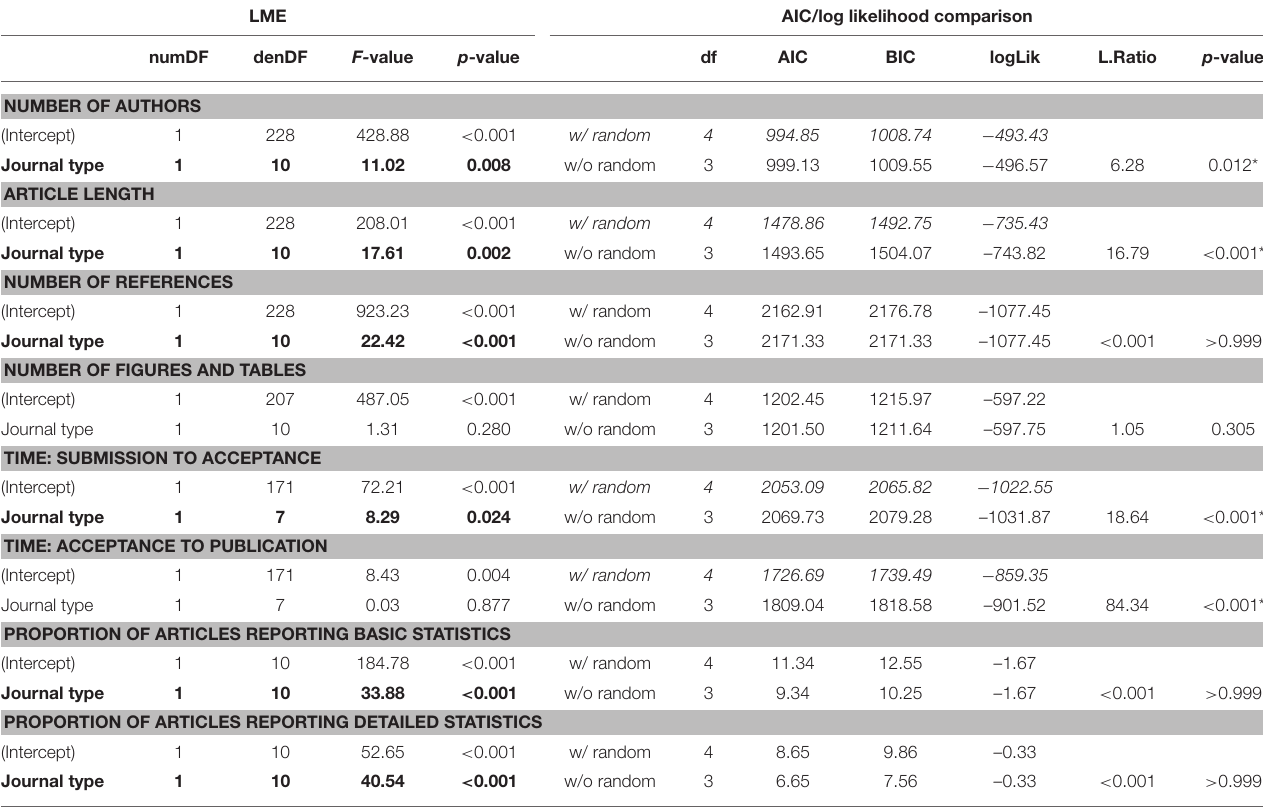
TABLE 3 | Results of linear mixed effects models and AIC/log likelihood model comparisons for effects of journal type and journal on non-demographic article-level metrics. LME AIC/log likelihood